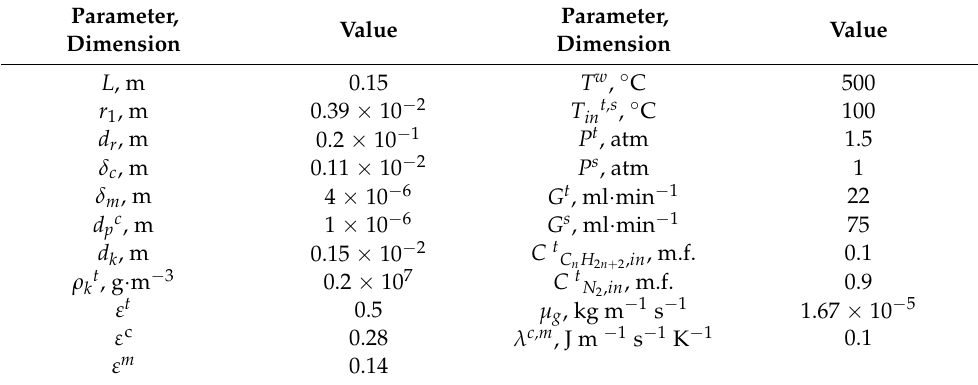
Table 1. Parameters of the mathematical